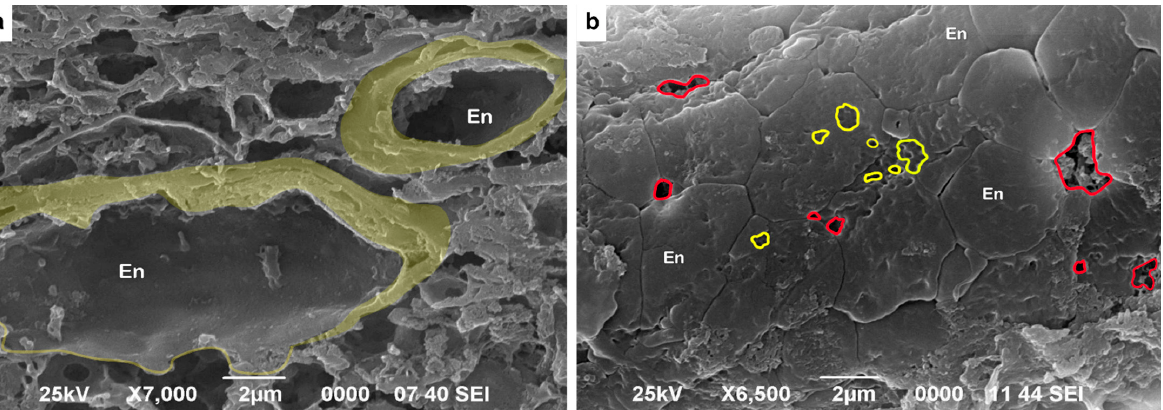
Figure 7. Representative scanning electron microscopy (SEM) micrographs of the vascular endothe- lium in the gray matter of predominantly ( a ) controls and ( b ) alcoholics. ( a ) Characteristic continuous endothelium (En) seen in the walls of SN microvessels in the lateral view. Original magnification, 7000 × . ( b ) Ultrastructural changes observed in between neighboring endothelial cells on the luminal surface. Large paracellular pores (shown by a red line) and fenestrae (shown by a yellow line) can be seen on the luminal surfaces of endothelial cells. Original magnification, 6500 × . Scale bars, 2 µ